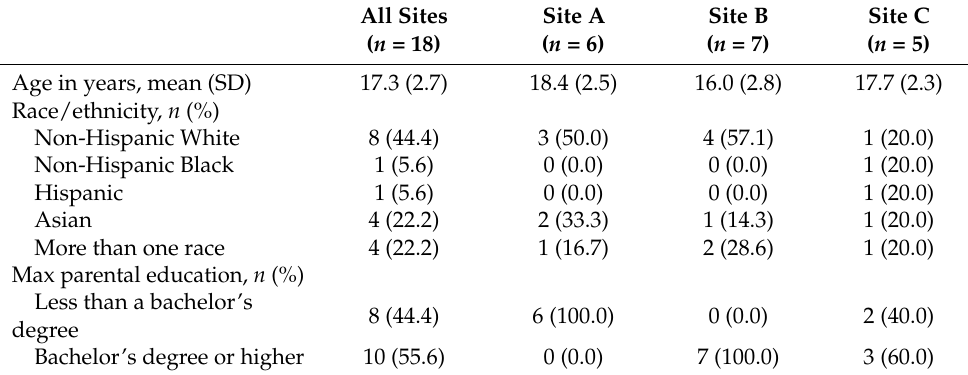
Table 1. Characteristics of the study